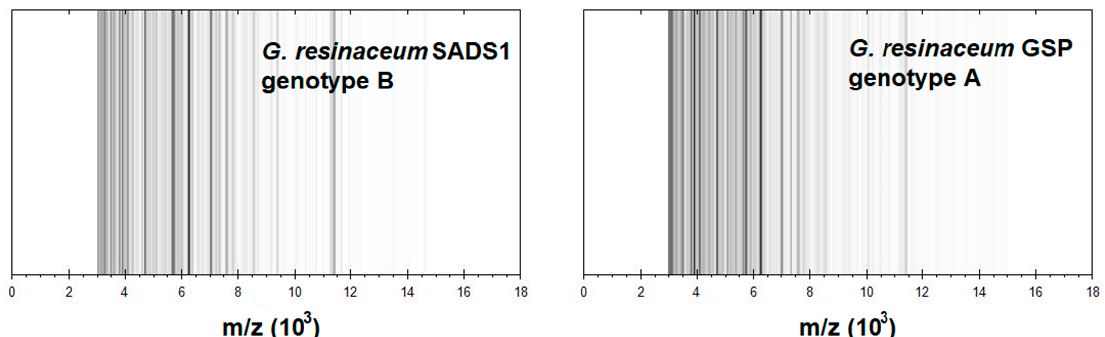
Figure 4. Comparison of normalized matrix-assisted laser desorption ionization time-of-flight mass spectrometry (MALDI–TOF MS) spectra of G. resinaceum genotype A. (right) GSP strain and genotype B; (left) SADS1 strain.